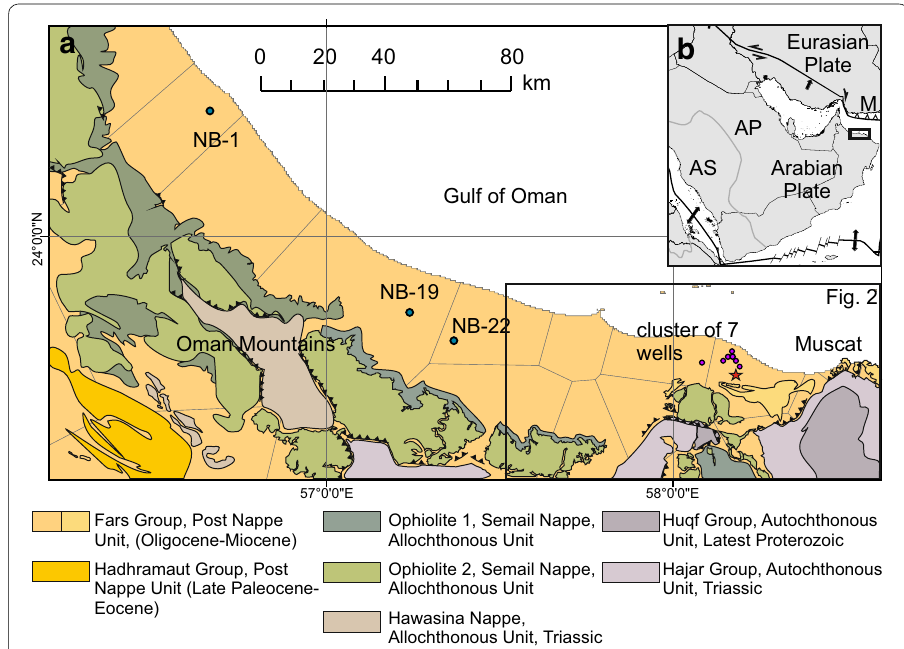
Fig. 1 Inset map is a general map of the Arabian Plate. AS Arabian Shield, AP Arabian Platform, M Makran Thrust Zone [modified from Mahmoud et al. (2005), Stern and Johnson (2010), Johnson et al. (2011)]. Main map is a geological map of the study area, with the major geological units (modified from NF40-03, Seeb sheet, 1992, Sultanate of Oman, Ministry of Petroleum and Minerals). Blue dots—wells, of which T-logs were provided by the MRMWR. Purple dots—wells in which new T-logs were recorded. Red star—site, where a thermally driven cooling system will be installed. Black triangle—major thrust fault [modified from NF40-03, Seeb sheet, 1992, Sultanate of Oman, Ministry of Petroleum and Minerals, Fournier et al. (2006)]. Black rectangle gives the outline of Fig.